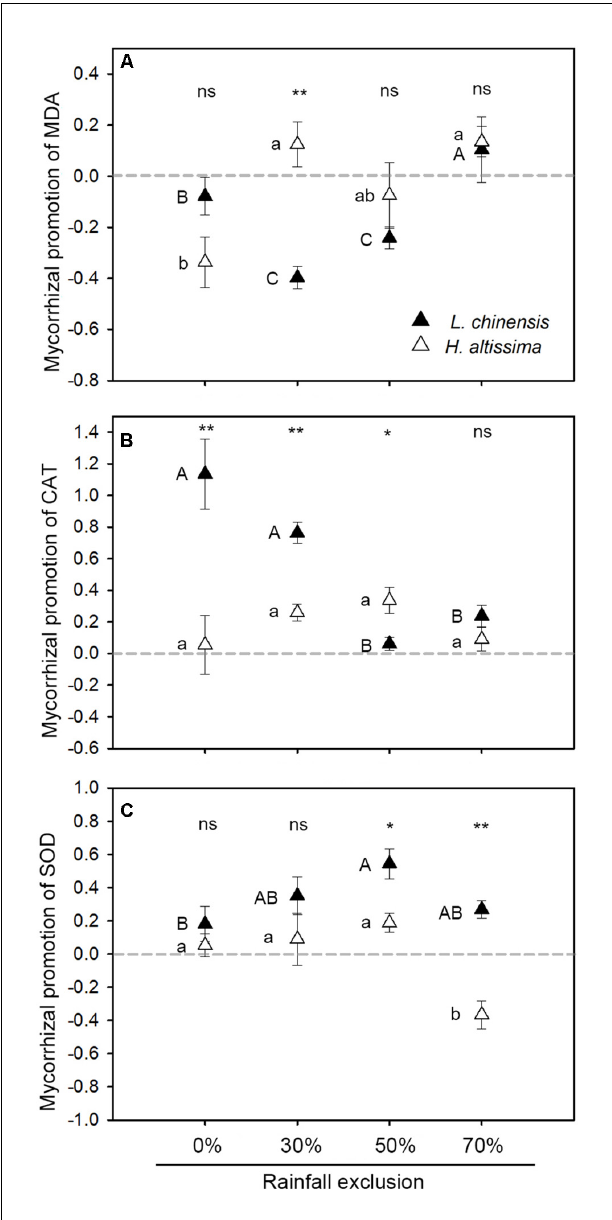
FIGURE 6 | Mycorrhizal response of malondialdehyde (MDA, A ) and antioxidant enzyme, including catalase (CAT, B ), and superoxide dismutase (SOD, C ), in L. chinensis and H. altissima . Mycorrhizal benefit existed when values of mycorrhizal response were greater than zero. ∗ P < 0.05 and ∗∗ P < 0.01 indicates significant differences and ns ( P > 0.05) indicates no differences between L. chinensis and H. altissima . Data are reported as mean ± 1 SE ( n =